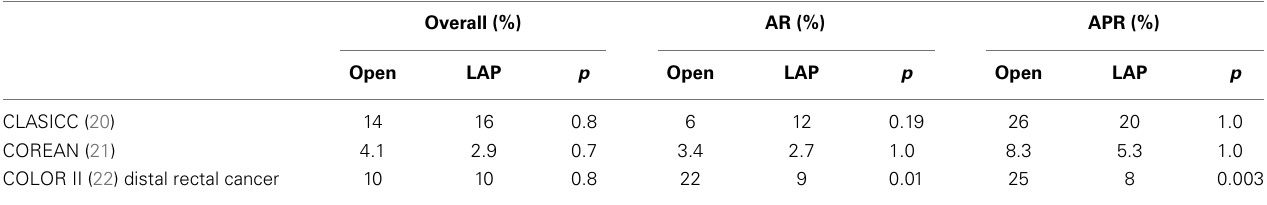
Table 1 | Comparison of circumferential resection margin positivity in open and laparoscopic total mesorectal excision (TME)